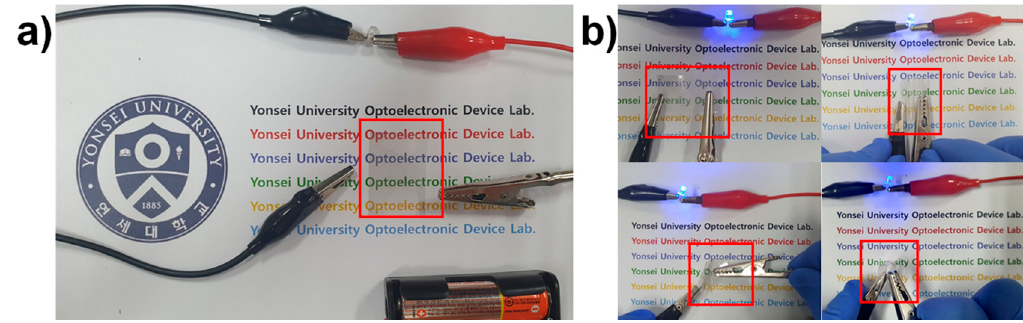
Figure 7. Demonstration of the mechanical robustness of the GCA–AgNW film. ( a ) Off state. ( b ) On state bending/deforming test of GCA–AgNW.